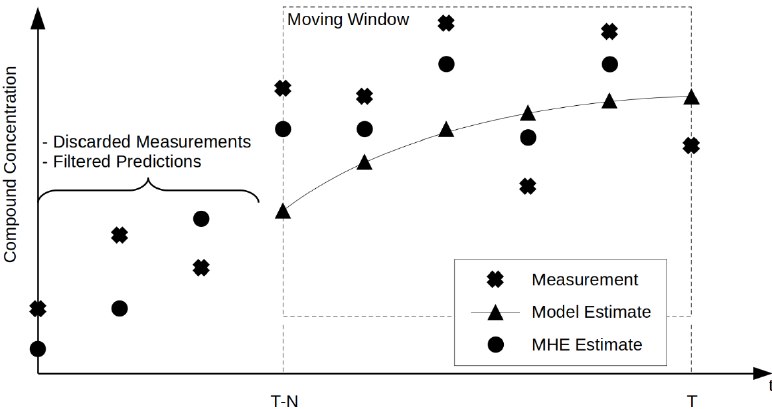
Figure 2. Moving horizon in state estimation schematic. Adapted from [29] ⁠ .